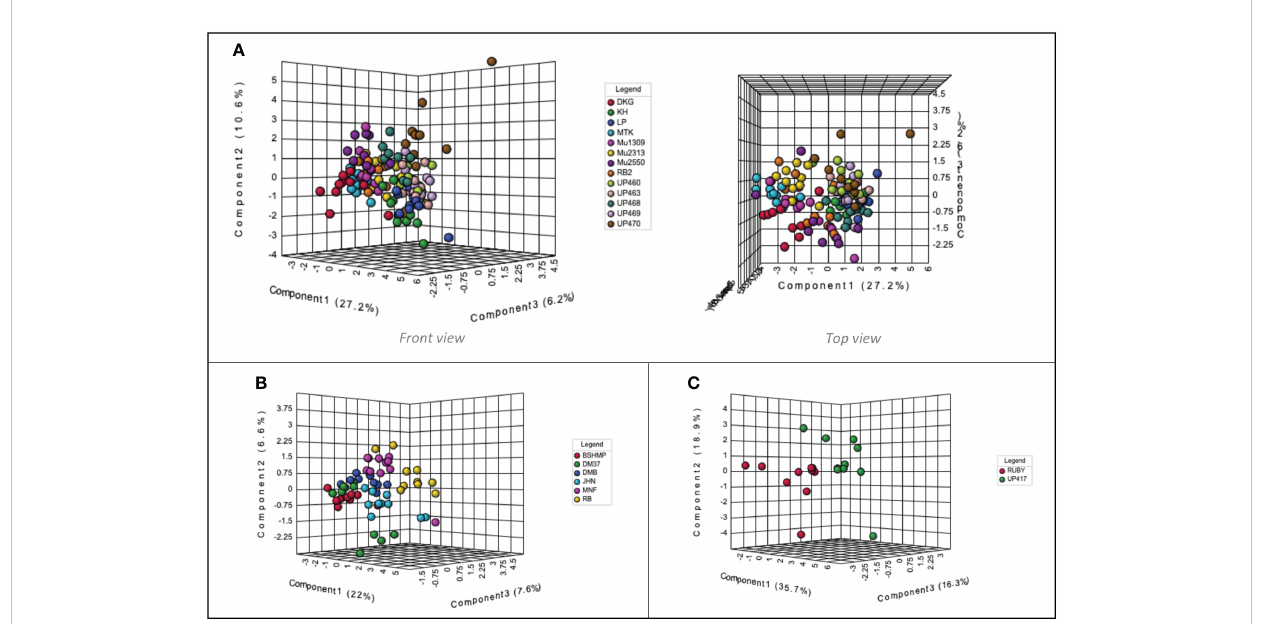
FIGURE 4 Partial least squares-discriminant analysis (PLS-DA) scores plot of Thai colored rice volatile pro fi les identi fi ed by static headspace gas chromatography – mass spectrometry technique. (A) aromatic black rice cultivars, (B) non-aromatic black rice cultivars, (C) non-aromatic red rice cultivars. One replication is represented by each colored symbol (n=10 per rice cultivar), while 95% con fi dence intervals are represented by shaded circles.